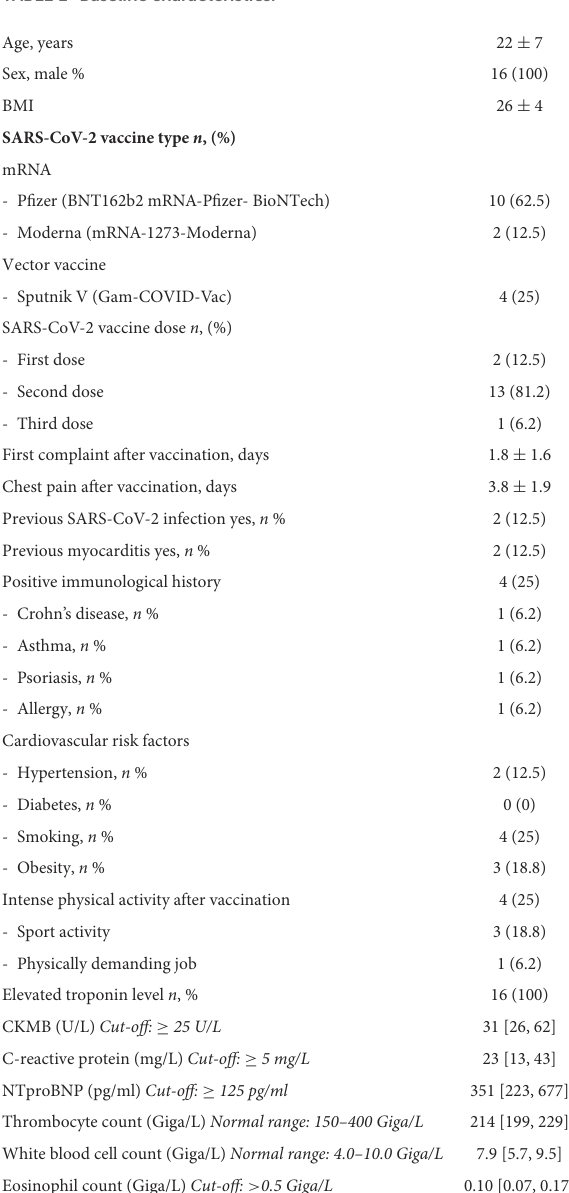
TABLE 1 Baseline